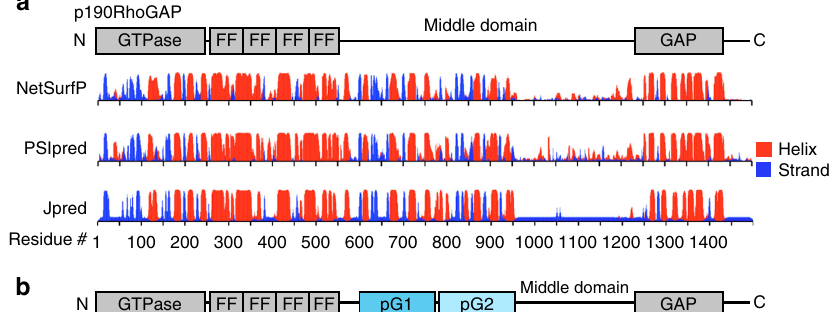
Fig. 1 p190RhoGAP proteins contain pseudoGTPase domains. a Current domain assignment for p190RhoGAP proteins ( top ). Secondary structure predictions of p190RhoGAP-A from humans ( below ) shown as probability of secondary structure ( y axis) against residue number ( x axis). Predicted helices in red and strands in blue . b Updated domain assignment for p190RhoGAP